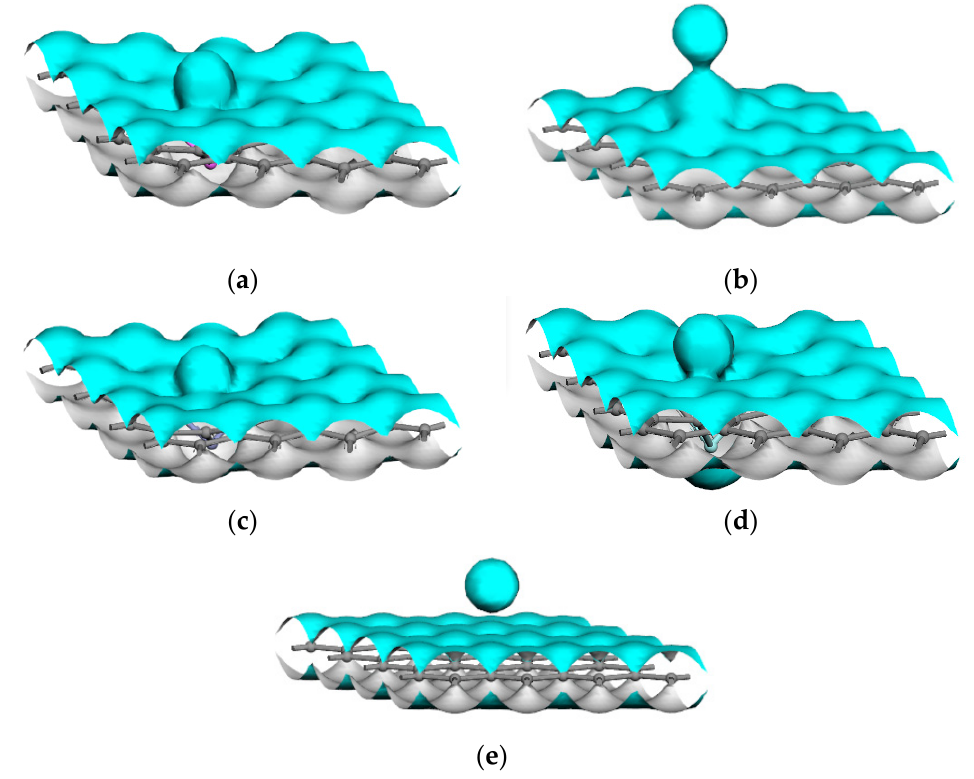
Figure 4. Isosurfaces of the electron densities of the Mg interactions with the intrinsic and doped graphene sheets: ( a ) Al-doped graphene sheet, ( b ) Mn-doped graphene sheet, ( c ) Zn-doped graphene sheet, ( d ) Zr-doped graphene sheet, ( e ) intrinsic graphene sheet.